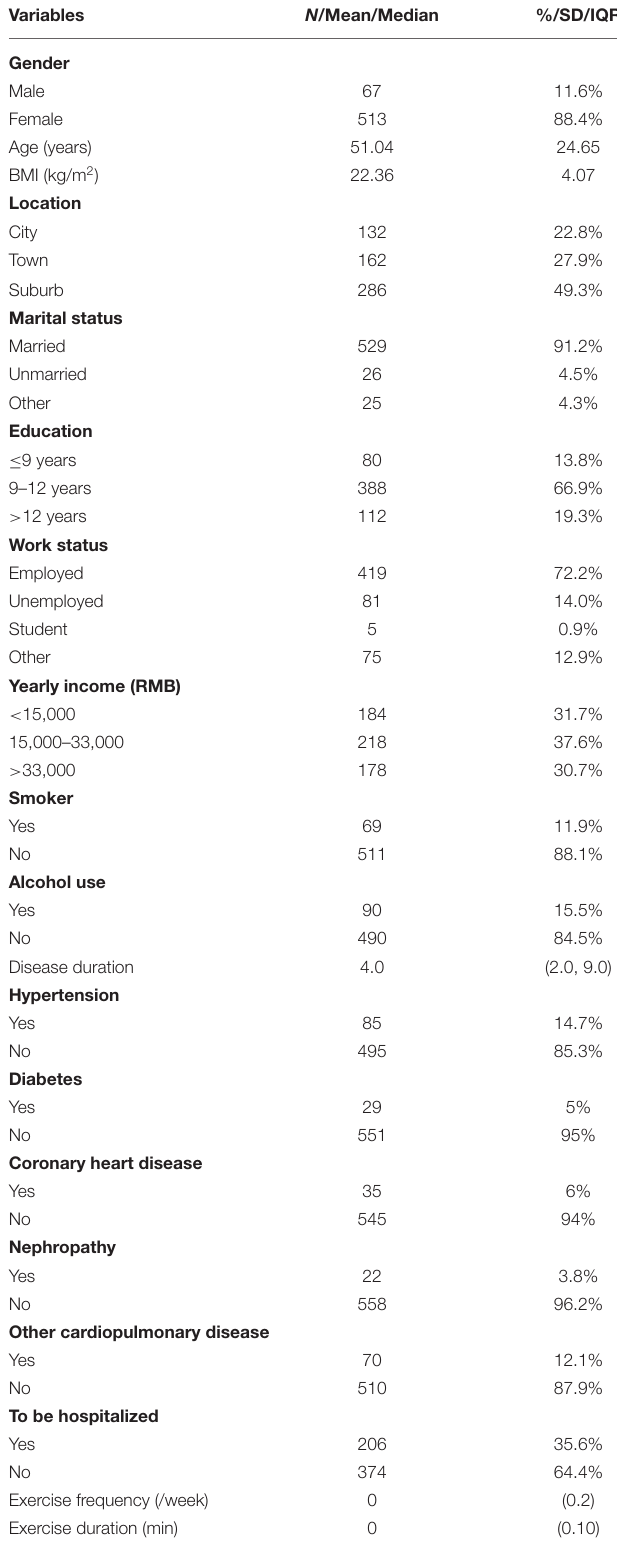
TABLE 1 | Characteristics of patients with RA ( n =